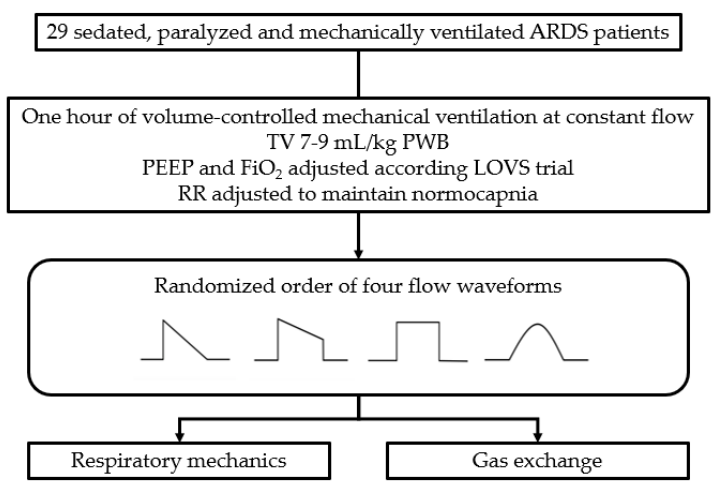
Figure 2. Study Figure 2. Study flow-chart.